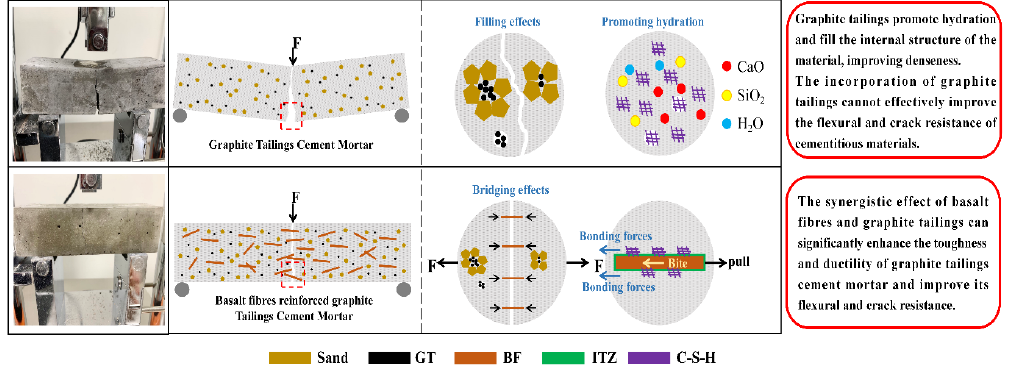
Figure 15. The synergistic enhancement mechanism of BF and GT to